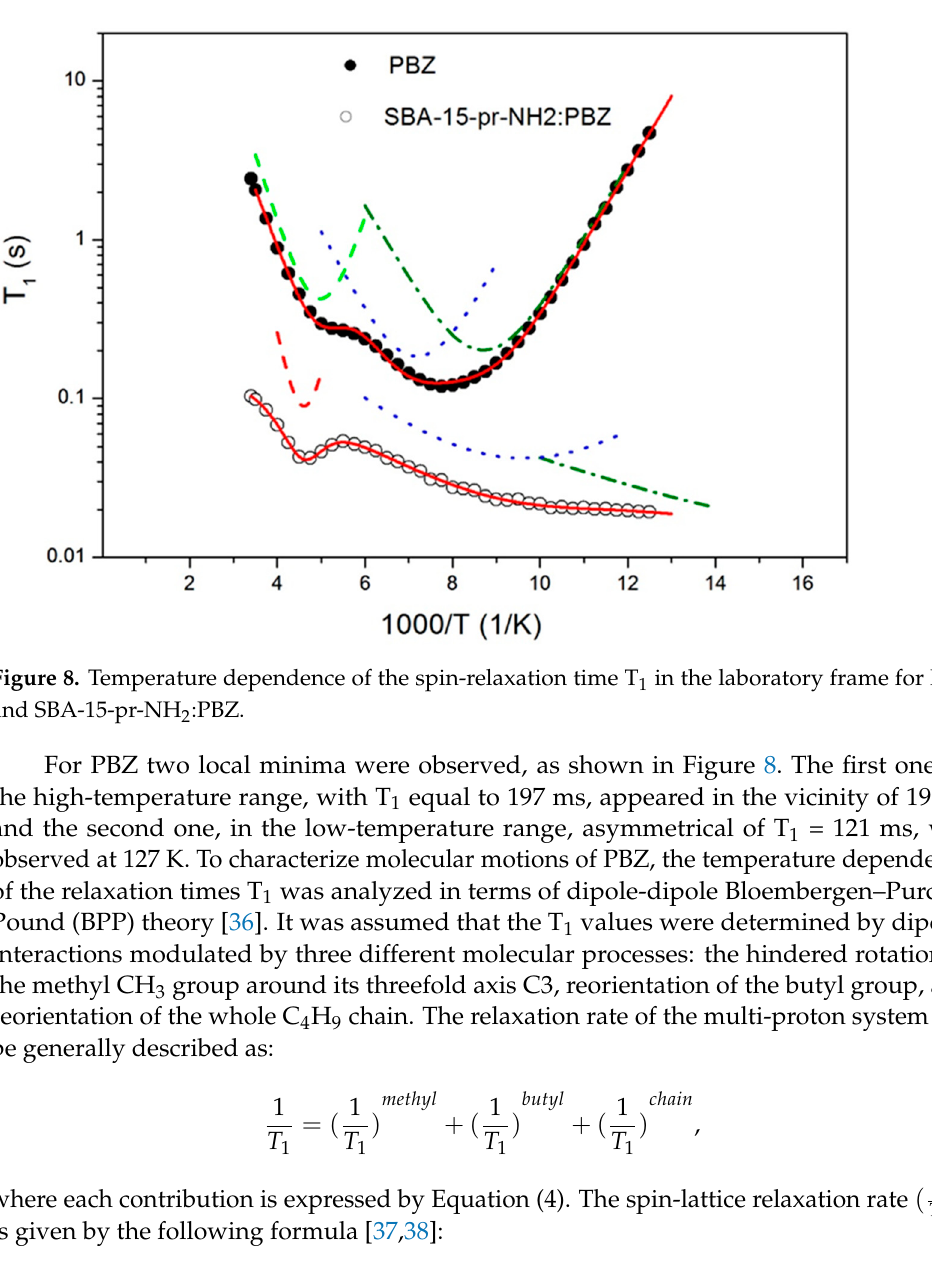
Figure 7. Scheme of phenylbutazone.